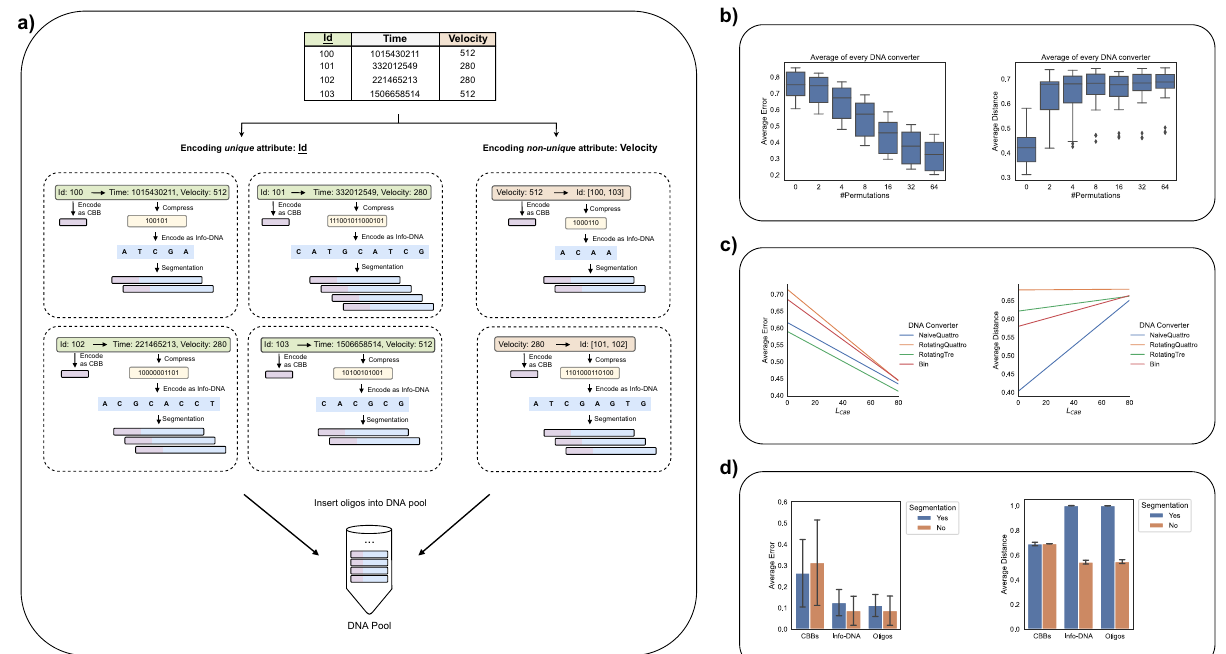
Figure 2. In ( a ), we depict an example of encoding the attributes Id and Velocity of an example table. Id is the primary key. Hence, we encode each value of Id as a CBB, and every CBB is attached as prefix to an Info-DNA. Each Info-DNA encodes the compressed (by GZIP) remaining attributes Time and Velocity of the corresponding record. For example, the values ( Time=1015430211, Velocity=512 ) of the record with ( Id=100 ) are compressed and then encoded with fountain code to an Info-DNA. In our example, this produces (ATCGA) as Info-DNA. If the resulting Info-DNA does not adhere to the constraints C1, C2, C4, and C5, we further apply segmentation. Velocity is not unique and is encoded as follows. First, each unique value is encoded as a CBB, and each CBB is attached to a list of Id s of the associated records. In our example, (Velocity=512) provides the list composed of (Id=100) and (Id=103) . The encoding then returns (ACAA) . Each list is further compressed and encoded as Info-DNA by the fountain code. We apply segmentation if the resulting Info-DNA violates any constraints C1, C2, C4, and C5. All of the obtained oligos are stored in a single DNA pool. Figures ( b ) and ( c ) show the average error and average distance as functions of the number of permutations ( n ) and the length threshold of a CBB ( L CBB ), respectively. The results are obtained from an experiment with 1 million CBBs computed for (Id=0,...,999999) . In Fig. ( c ), the results are depicted as a linear regression line. Moreover, to check for similarities among CBBs, we used LSH with parameters ( k = 4, r = 200, b = 20 ). ( b ) shows how the average error reduces, and the average distance increases with an increasing number of permutations. ( c ) illustrates how the error decreases and relative distances increase with the length of CBBs. In ( d ), we illustrate the effects of segmentation on the average error and average distance. We encoded the first 1 million rows ( ≈ 600 megabytes) of the data set A321_valid. csv and set the parameters such that the resulting Info-DNA sequences after segmentation are of length L Info = 170 . We encoded the unique attribute Id and the non-unique attribute icao24 as CBBs. The CBBs are all of length L CBB = 80 (padded by Pad ( cbb , L CBB ) , see "Methods"). We generated a total of ≈ 15.3 million oligos (every oligo is of length L Oligo = 250 ) in the case with segmentation. We used 32 permutations for CBBs and segmentation, and used c = 10 , i.e., the number of base pairs to pad every Info-DNA segment with, in the segmentation case. Without segmentation, we generated 1 million oligos for encoding Id , each representing a complete data record, and 1044 oligos for encoding icao24 . Thus, the sizes of these artificial oligos are not bounded to 250 base pairs anymore but range between 192 and 3018 (average ≈ 2185 ). We used LSH with parameters ( k = 6, r = 200, b = 20 ) and set the number of permutations to n = 32 for CBBs. Our results in ( d ) show a considerable improvement in the distances for the oligos. As expected, segmentation has almost no impact on CBBs. In fact, it is interesting to see that the quality of CBBs does not worsen though many more CBBs are required in case of segmentation. However, the error of the oligos with segmentation is slightly higher than the ones without segmentation. To combat this deficiency, we could increase the number of base pairs padded to the Info-DNA sequences ( c ) or the number of permutations ( n ), consequently raising the computation